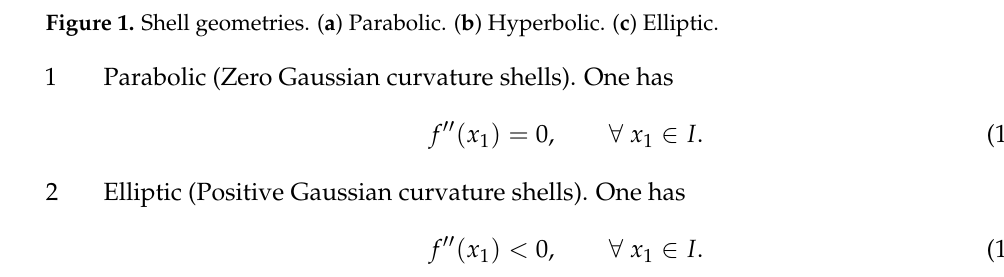
Elliptic (Positive Gaussian curvature shells). One